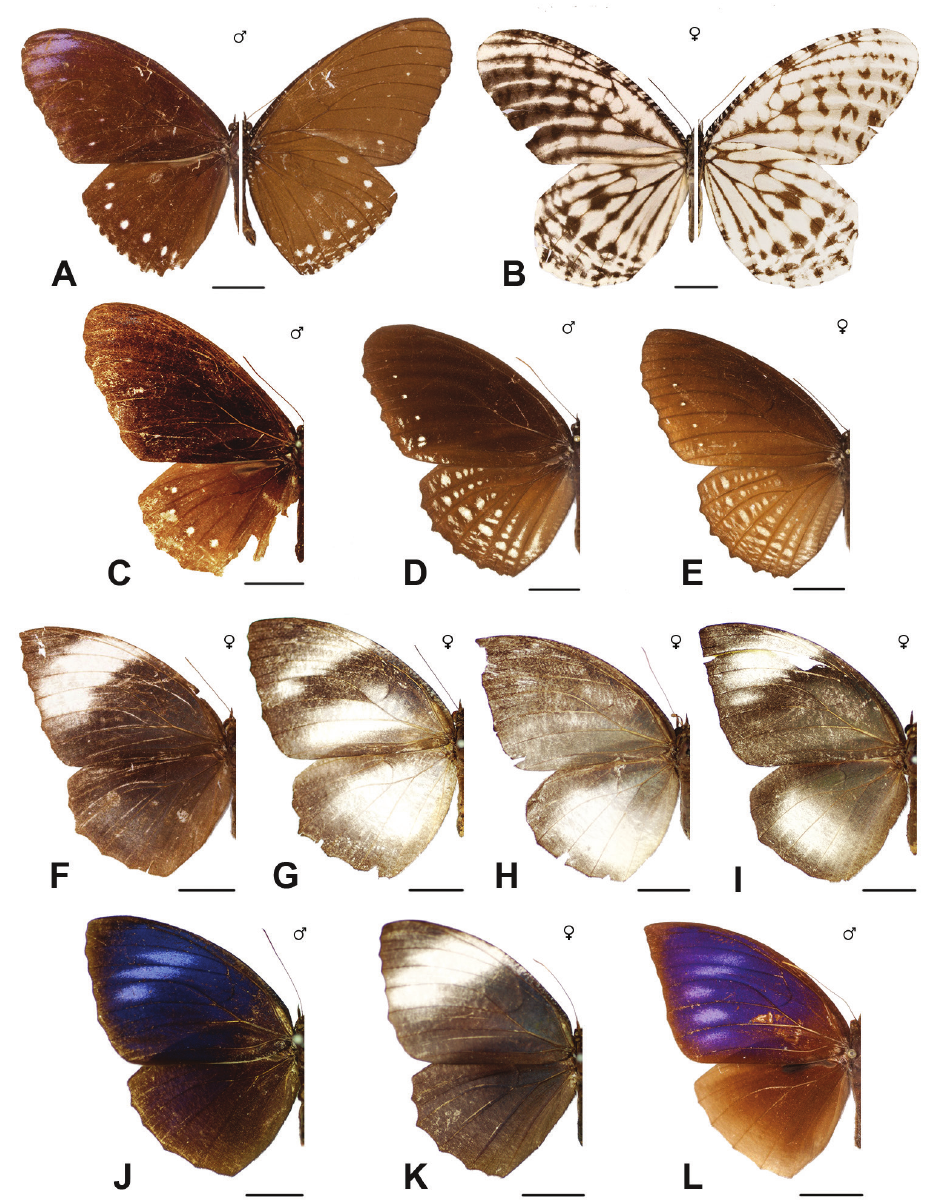
Figure 4. A kuenstleri kuenstleri ♂ D+V NHM Specimen locality unknown B kuenstleri kuenstleri ♀